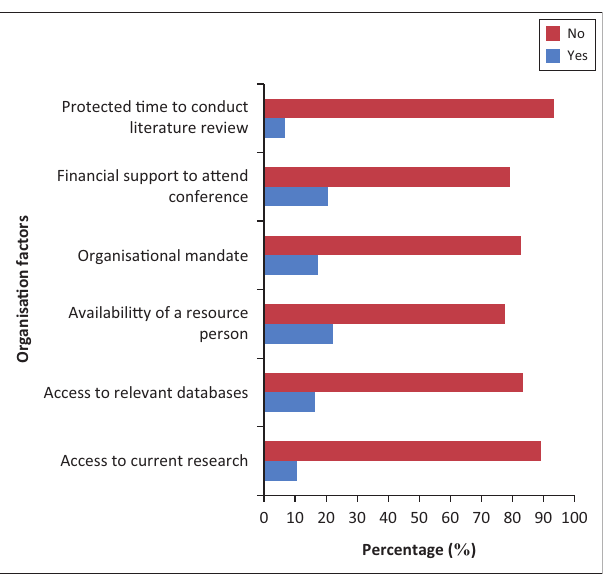
FIGURE 2: Organisational factors affecting the implementation of EBPT for stroke